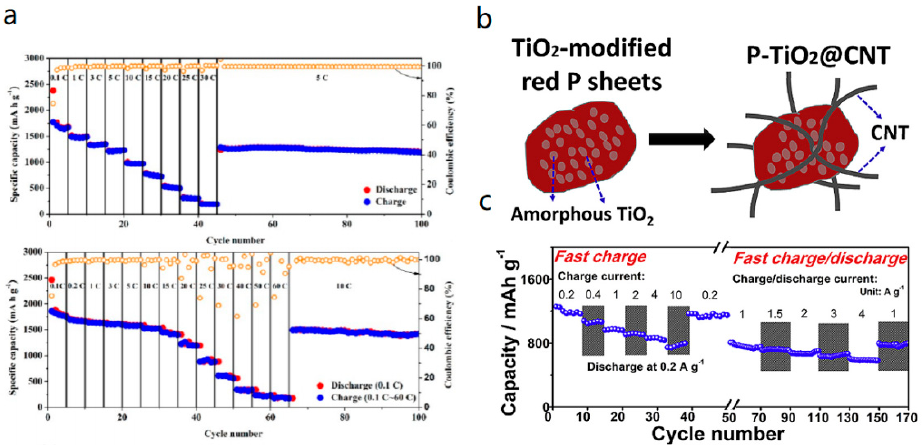
Figure 10. Rate performance of RPNPs electrode at various rates [107] ( a ). Structure of P-TiO 2 @CNT [108] ( b ). Rate performance of P-TiO 2 @CNT [108] ( c ). Reproduced by permission of Royal Society of American Chemical Society and Elsevier.